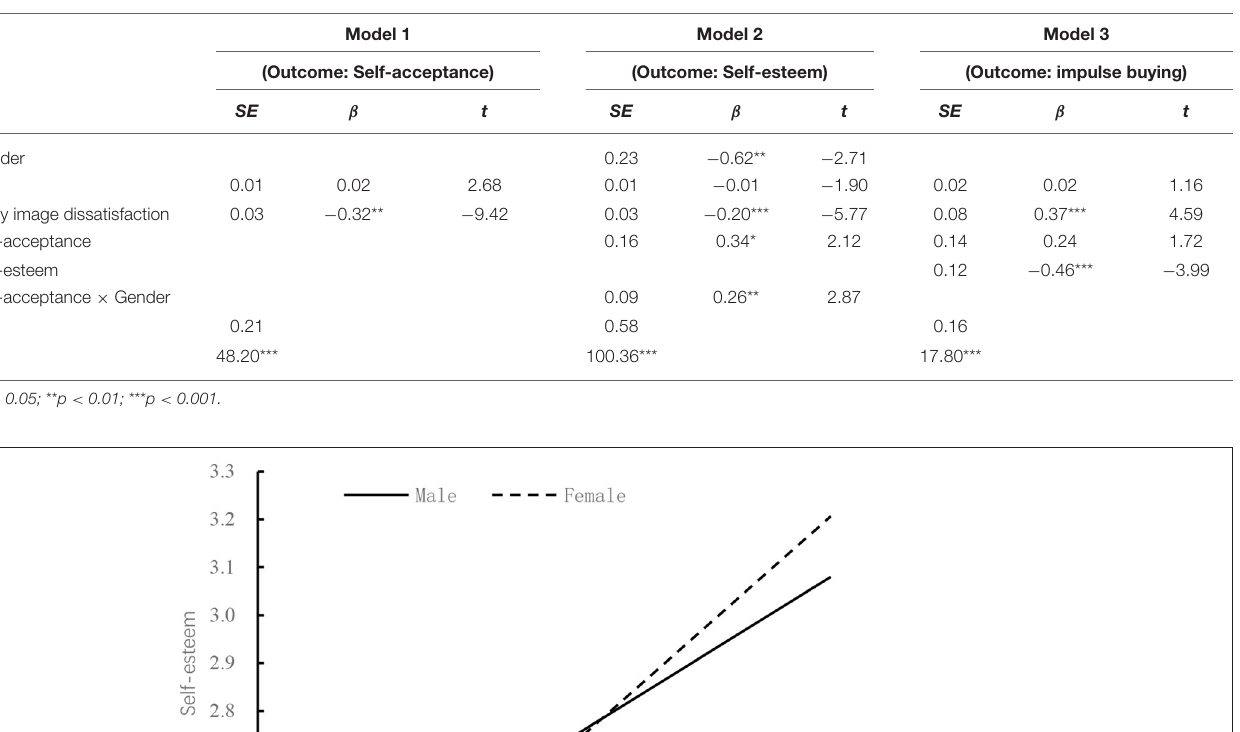
TABLE 2 | Test of the moderated mediation.